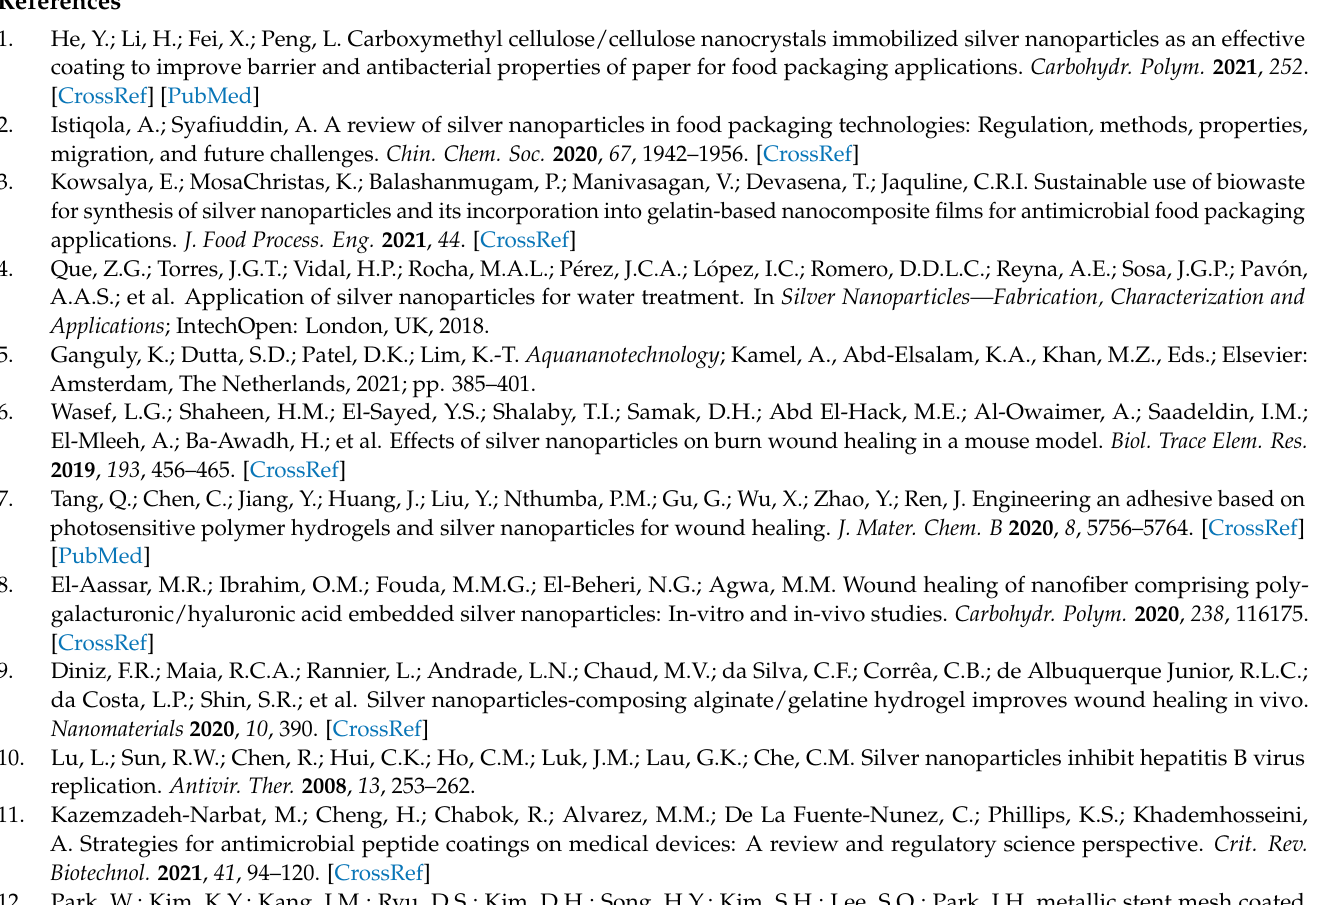
Table S2: Ag-SOA-PC-HT concentrations determined by ICP-MS, Figure S5: Representative size distrubtion intensity